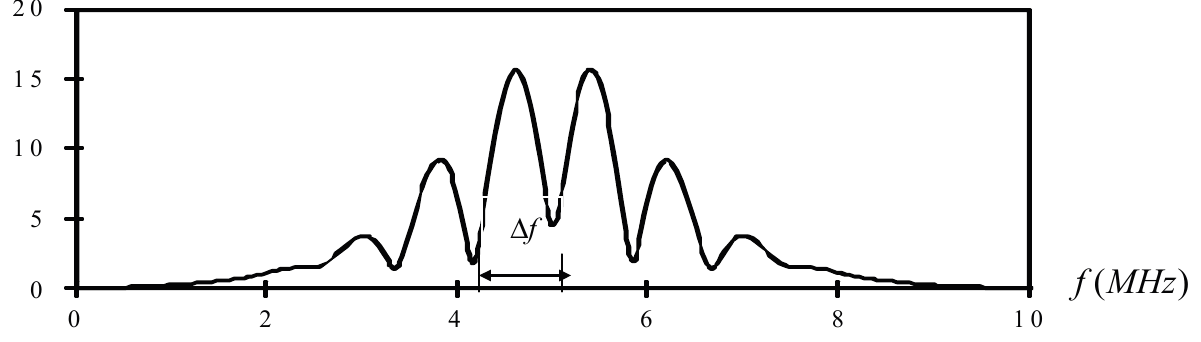
Figure 6. Fourier transform of two pulses with time delay st μ 2.1 =Δ